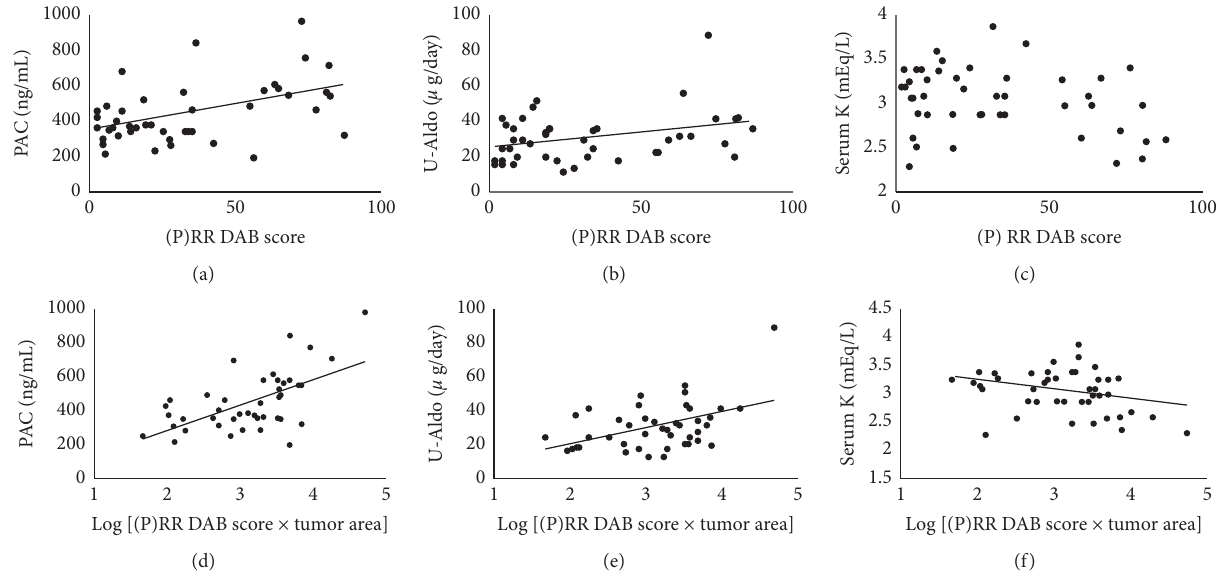
Figure 3: Correlation of (P)RR expression both before and after adjusting tumor area with PAC, U-aldo, and serum K. (P)RR: (pro)renin receptor; PAC: plasma aldosterone concentration; U-aldo: urinary aldosterone concentration; and K: